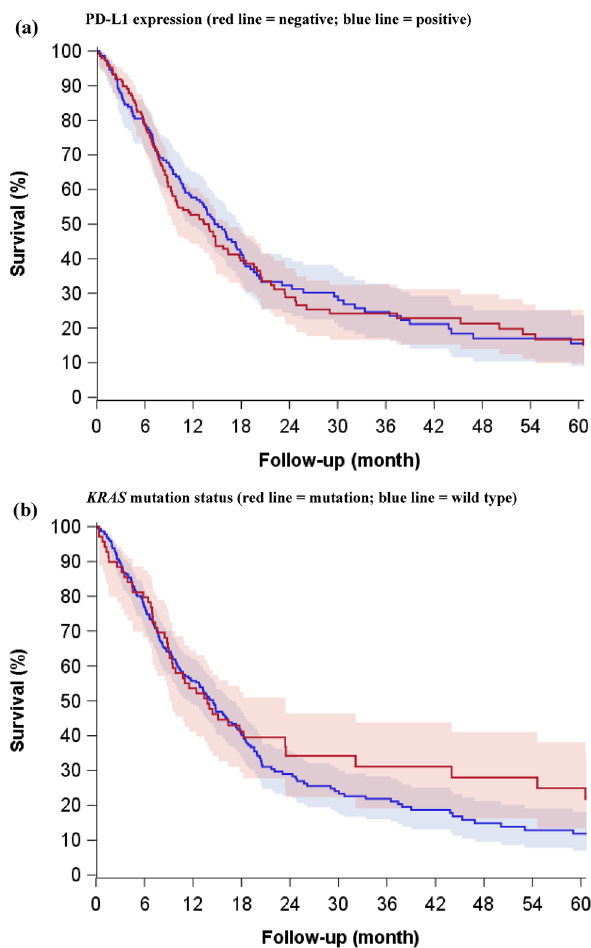
Figure 1. Kaplan–Meier curves illustrating the association of ( a ) PD-L1 expression (negative < 1%; positive > = 1%), ( b ) KRAS mutation status with survival in stage III unresected NSCLC patients diagnosed 2000–2013 with follow-up through 2014, and registered in the Danish Lung Cancer Group Registry. (NSCLC: non-small cell lung cancer; PD-L1: programmed cell death ligand 1; KRAS: Kirsten rat sarcoma virus).